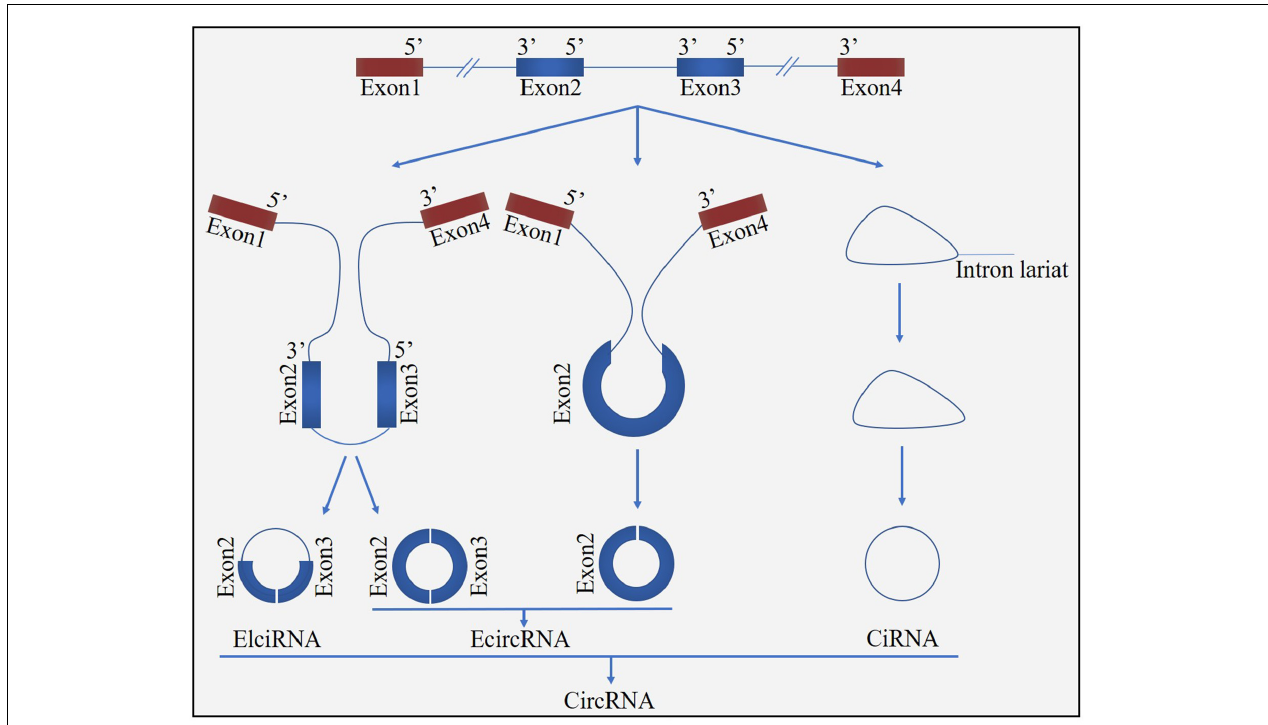
FIGURE 1 | Biogenesis of circRNA. CircRNAs can be formed from either exons (ecircRNAs), introns (ciRNAs), or both exons-introns (elciRNAs).